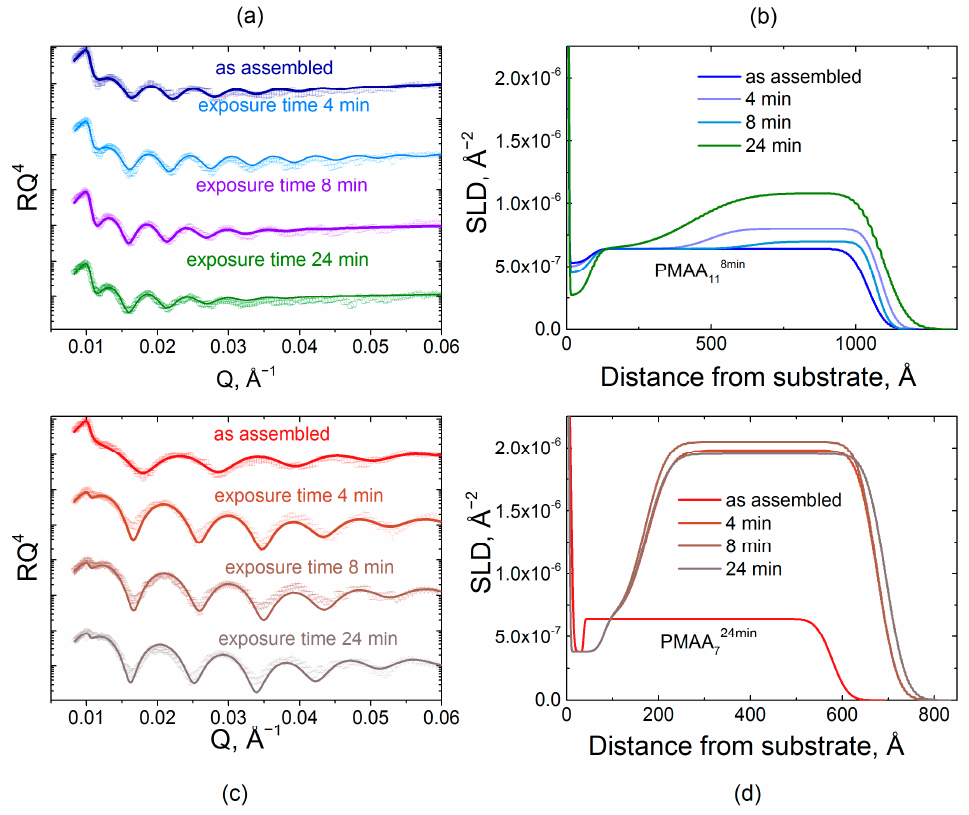
Figure 5. The effect on the film internal structure of the exposure of hydrogenated PMAA 118min and PMAA 724min films to a 0.2 mg/mL d QPC solution, as illustrated by neutron reflectometry. Reflectometry data (plotted as RQ 4 to enhance small features) ( a , c ) and scattering length density profiles ( b , d ) for PMAA 118min and PMAA 724min films exposed to d QPC solution for 4, 8, and 24 min in phosphate buffer at pH 6.0.